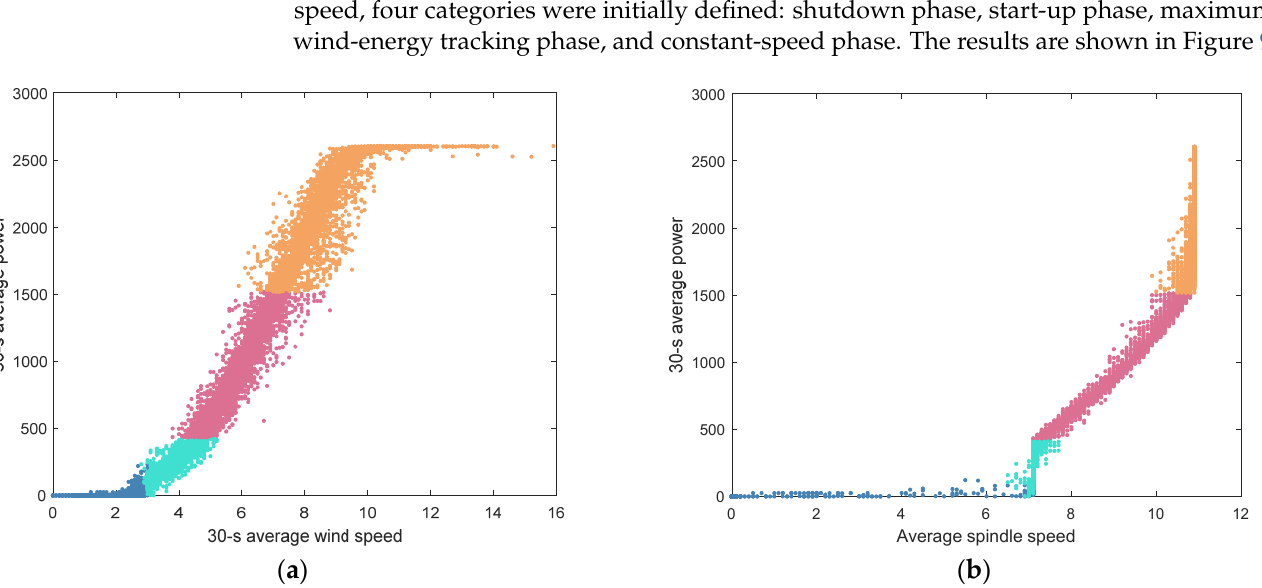
( b ) Figure 10. Results after subdivision of working conditions using the k -means clustering algorithm. ( a ) 30-s average wind speed vs. 30-s average power; ( b ) average spindle speed vs. 30-s average power. To more clearly demonstrate the division of the historical working conditions, the clustered results were plotted three-dimensionally with axes representing wind speed, spindle speed, and power and are shown in Figure 11.